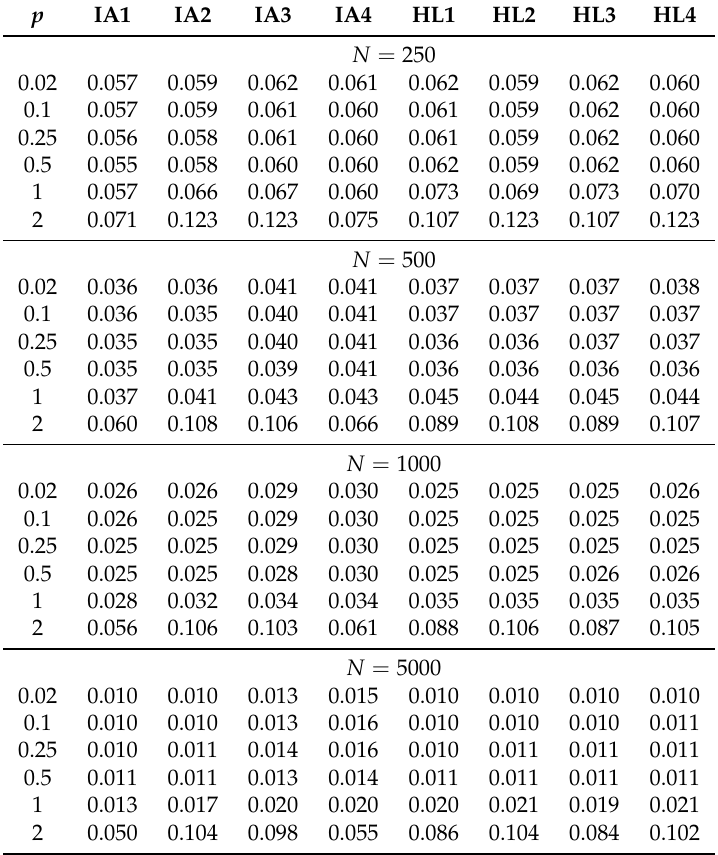
Table A1. Simulation Study 1: Average Root Mean Square Error (ARMSE) of Group Standard Deviations as a Function of Sample Size in the Condition of Differential Item Functioning (DIF) and G = 6